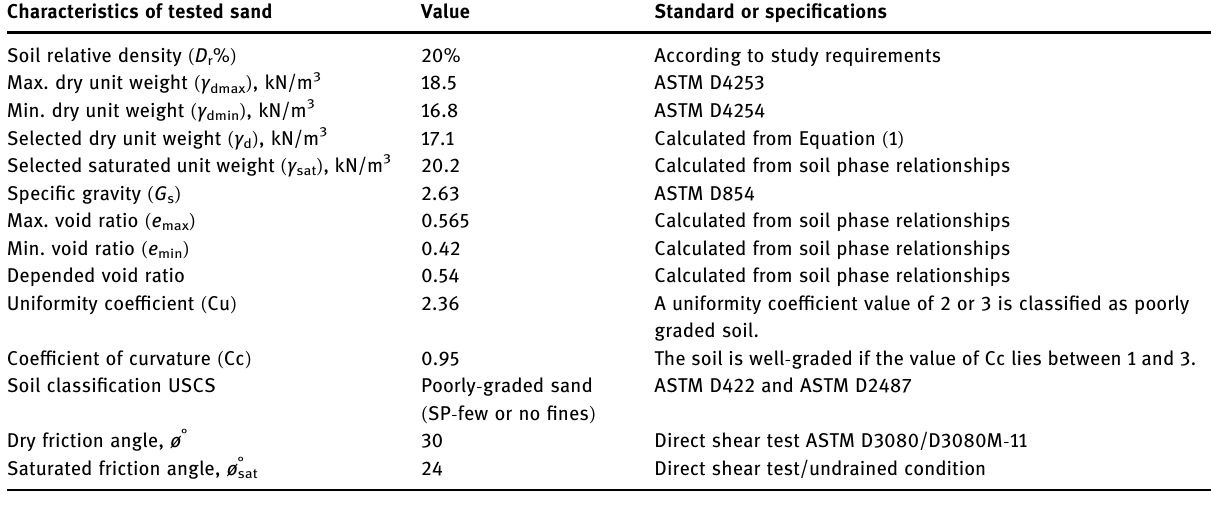
Table 1: Index geotechnical characteristics of sand mixtures Characteristics of tested